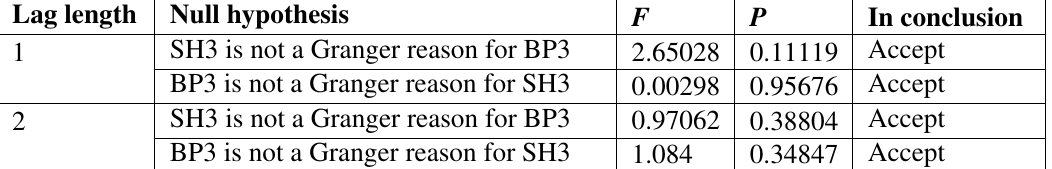
Table 3 SH3 and BP3Granger causality